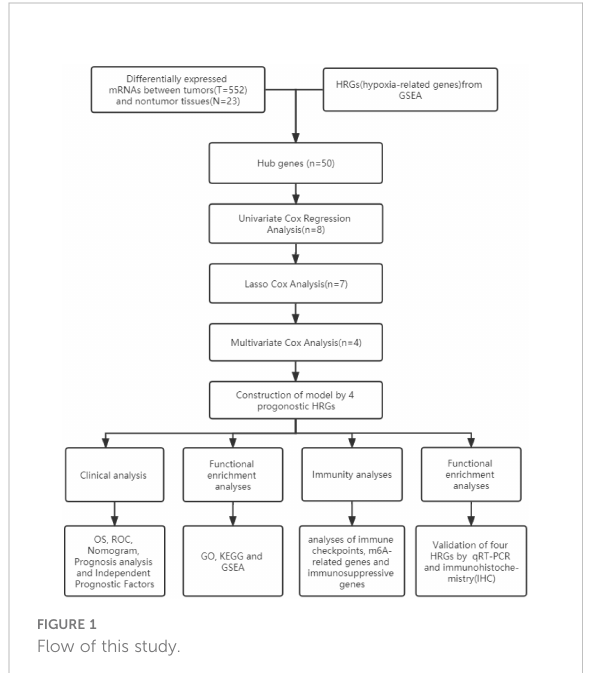
FIGURE 1 Flow of this